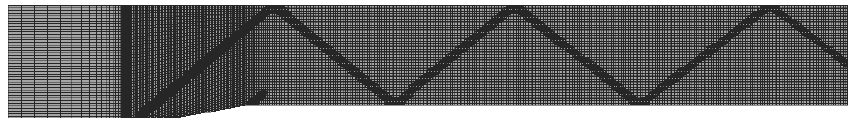
Figure 7. Local refinement of computational grid.